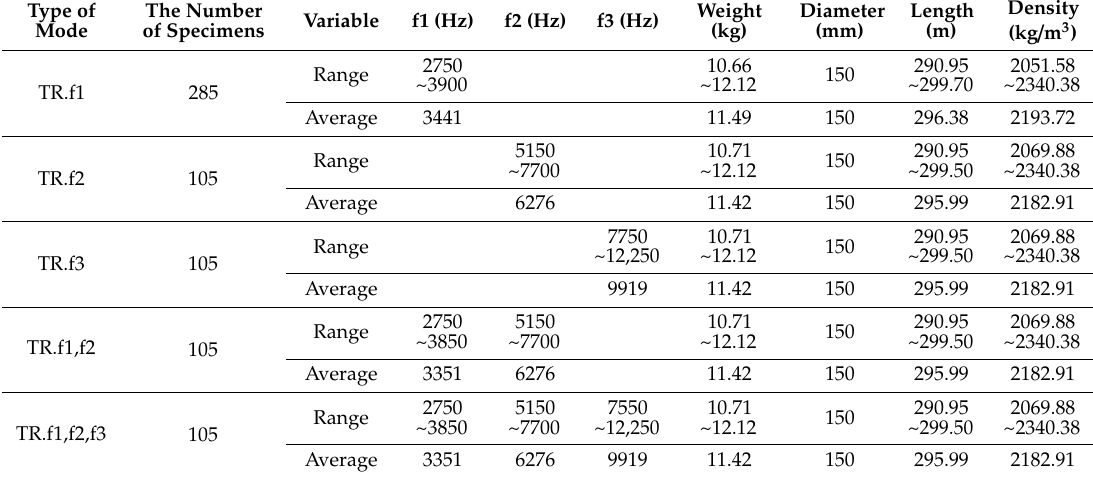
Table 8. Summary of used data in the LT mode for machine learning